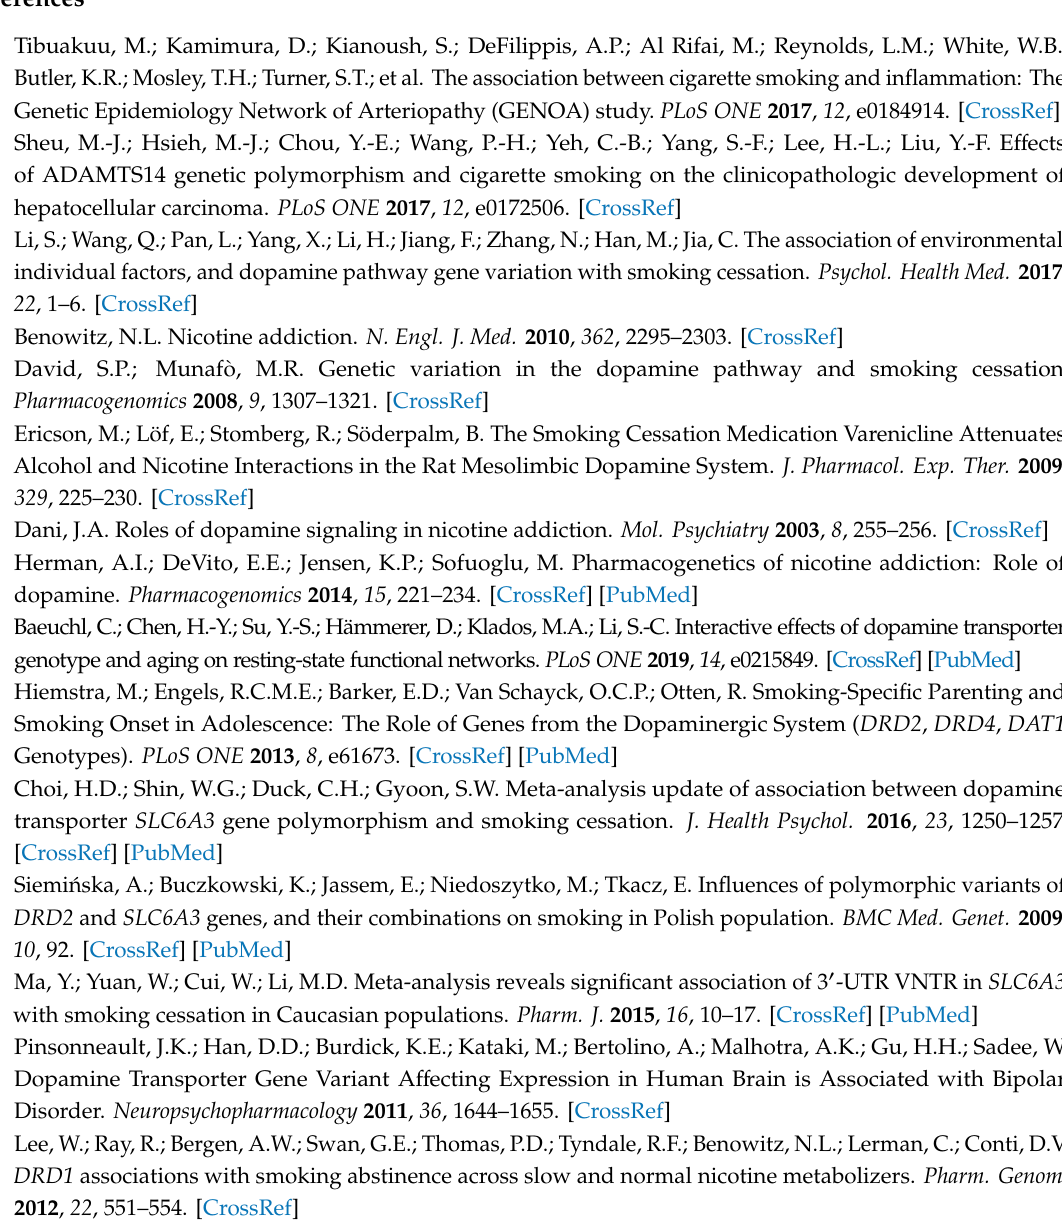
(rs686) (A) the chromatograms of DRD1 gene (rs686) homozygous wild type sequence and (B) DRD1 gene (rs686) heterozygous mutant sequence, Figure S11: Sequencing analysis of DRD2 (rs1800497) (A) the chromatograms of DRD2 gene (rs1800497) homozygous wild type sequence and (B) DRD2 gene (rs1800497) heterozygous mutant sequence, Figure S12: Sequencing analysis of DRD3 (rs7653787) (A) the chromatograms of DRD3 gene (rs7653787) homozygous wild type sequence and (B) DRD3 gene (rs7653787) heterozygous mutant